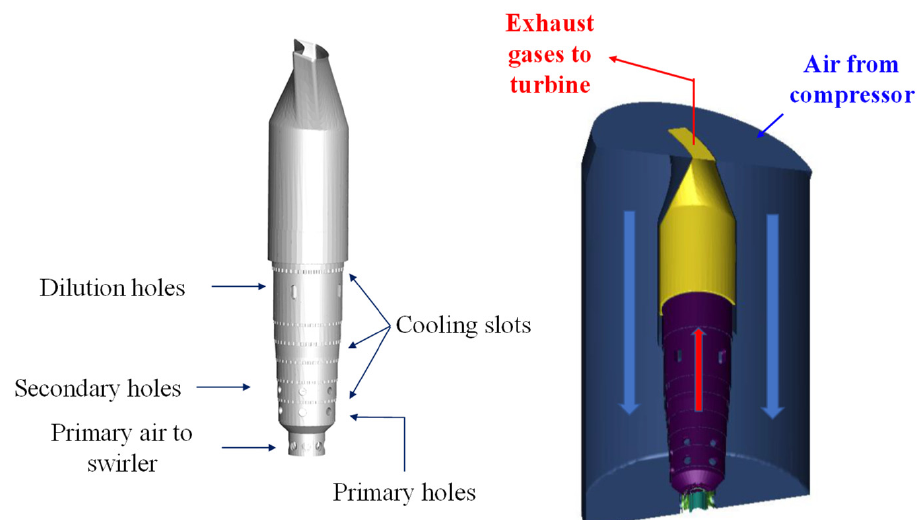
Figure 2. Tubular combustor geometry and main connections.